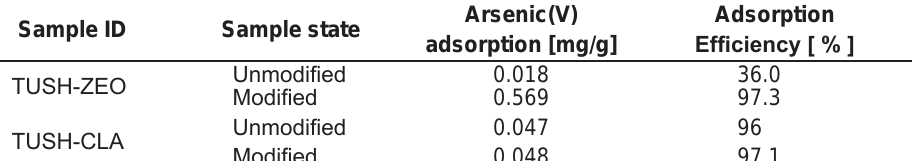
Table 4. Arsenic (V) adsorption by natural minerals and modified samples with MgO